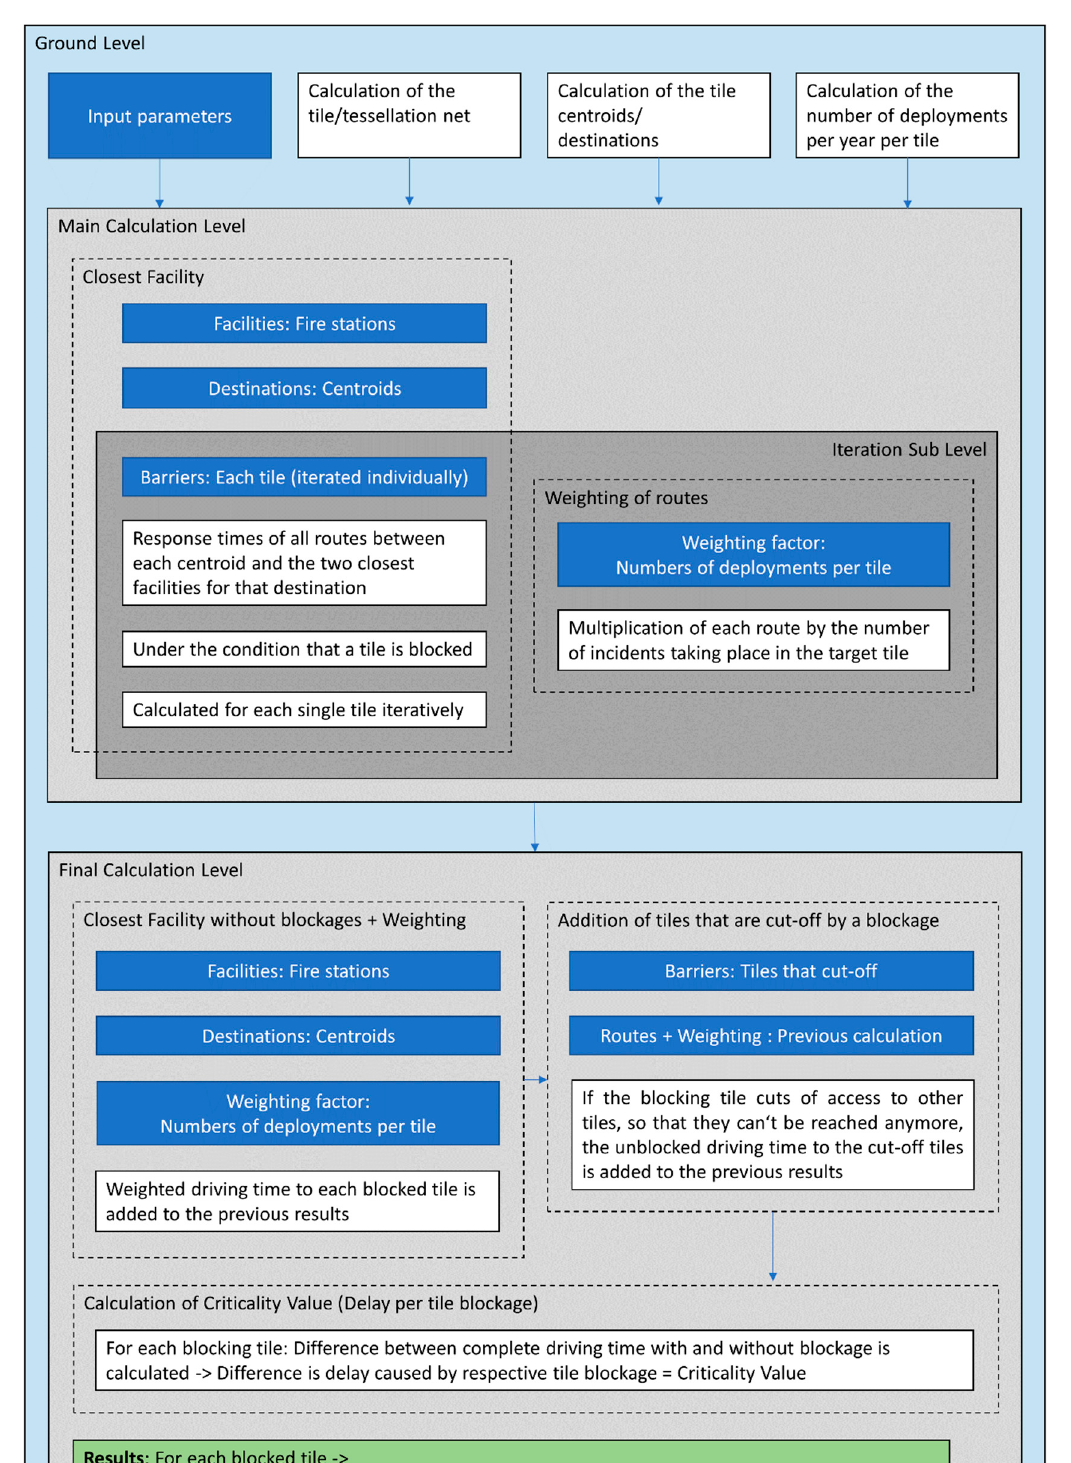
Figure 5. Model Conception of calculation steps.